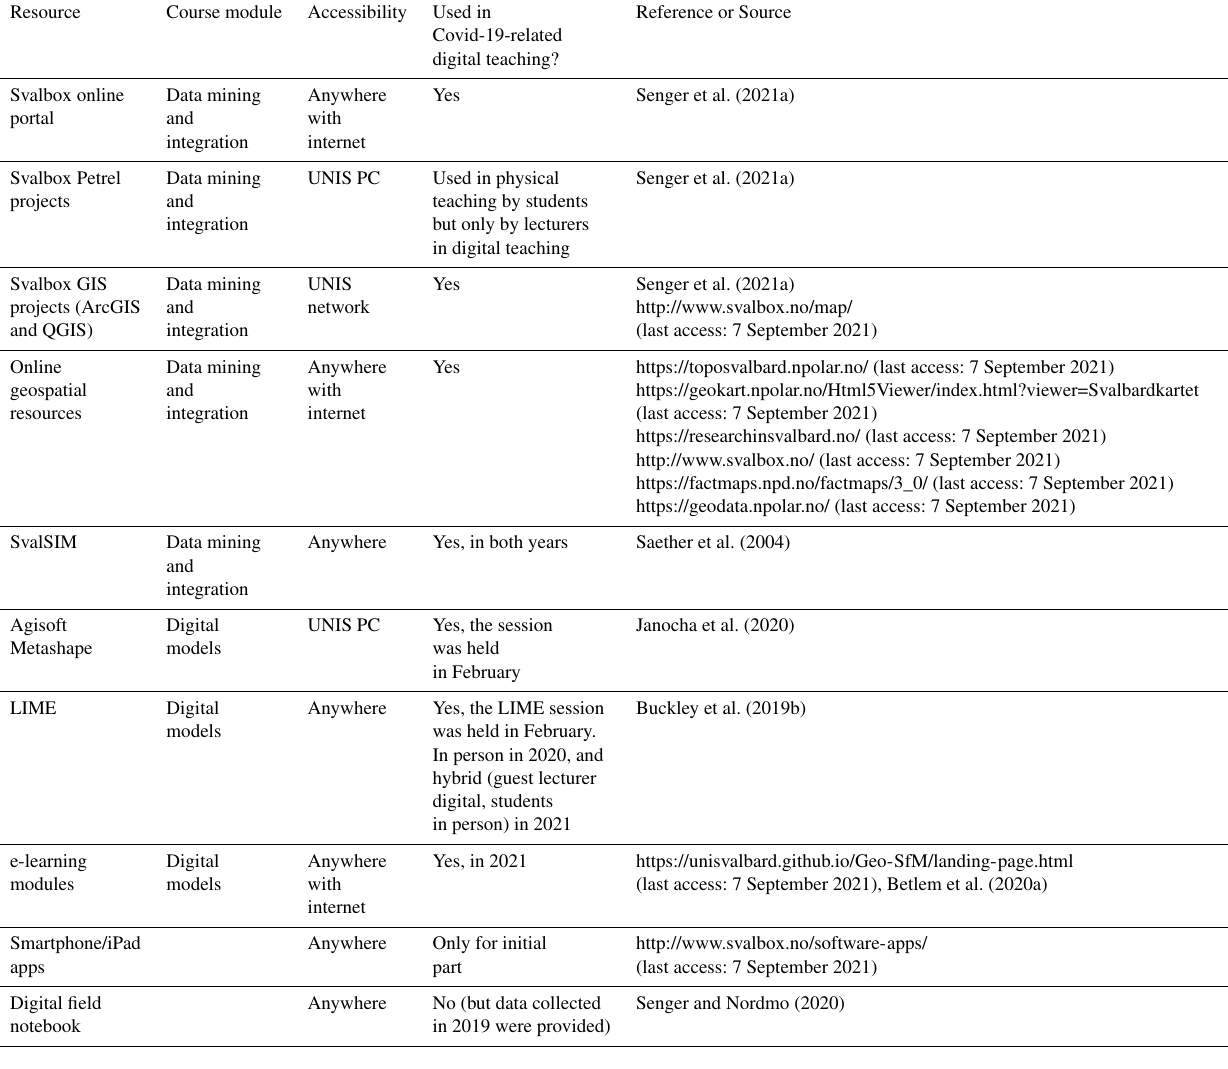
Table 4. Overview of key resources, data sets and software used in the AG222 course. Resource